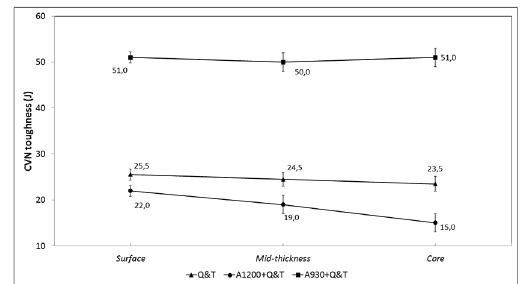
Figure 12. CVN toughness results for specimens quenched and tempered at 520ºC: without solution (▲); solution treatment at 1200ºC (●) and solution treatment at 930ºC (■).